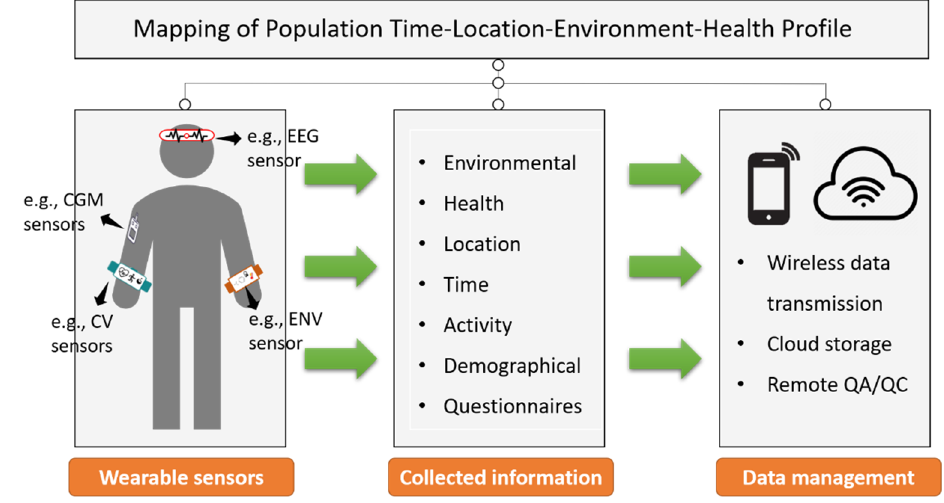
Figure 3. Illustration of human subject study framework using wearable environmental and health sensors. Abbreviations: EEG = electroencephalograph; CGM = continuous glucose monitoring; CV = cardiovascular; ENV = environment; QA/QC = quality assurance/ quality control.